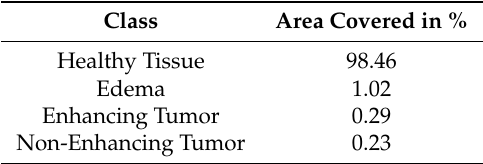
Table 1. Distribution of area to classes in MRI brain tumor